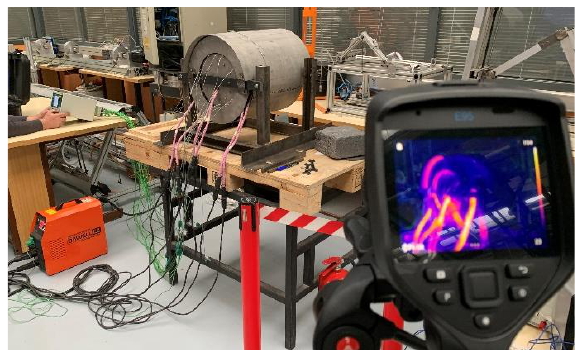
Fig. 15. Analysis by Flir thermal camera .